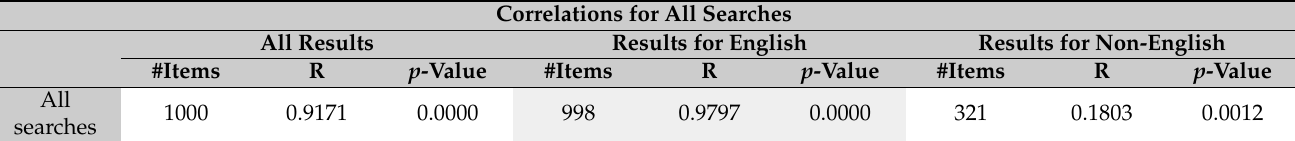
Table 9. Correlations between median rank positions by citations and the GS native ranking for all searches